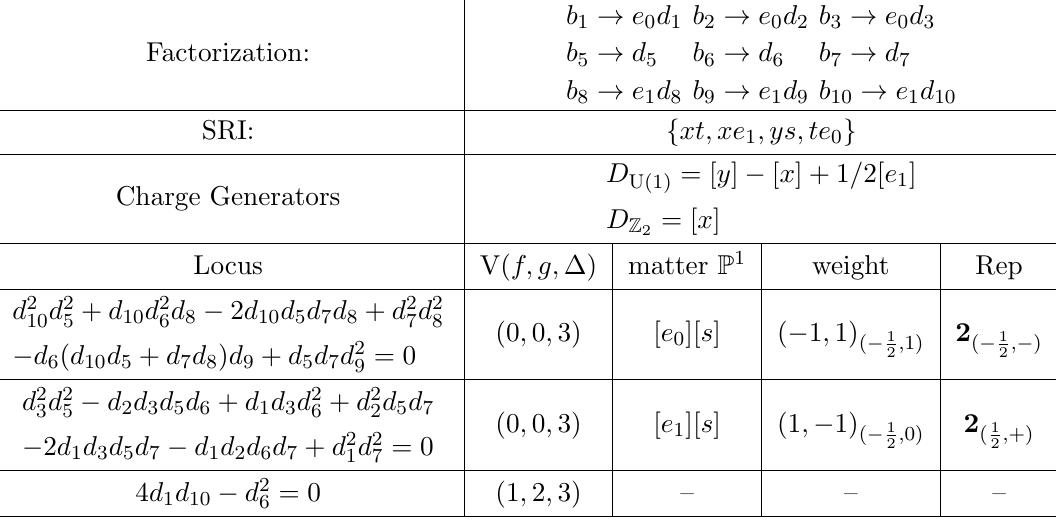
Table 11 . Summary of SU(2) top 1.